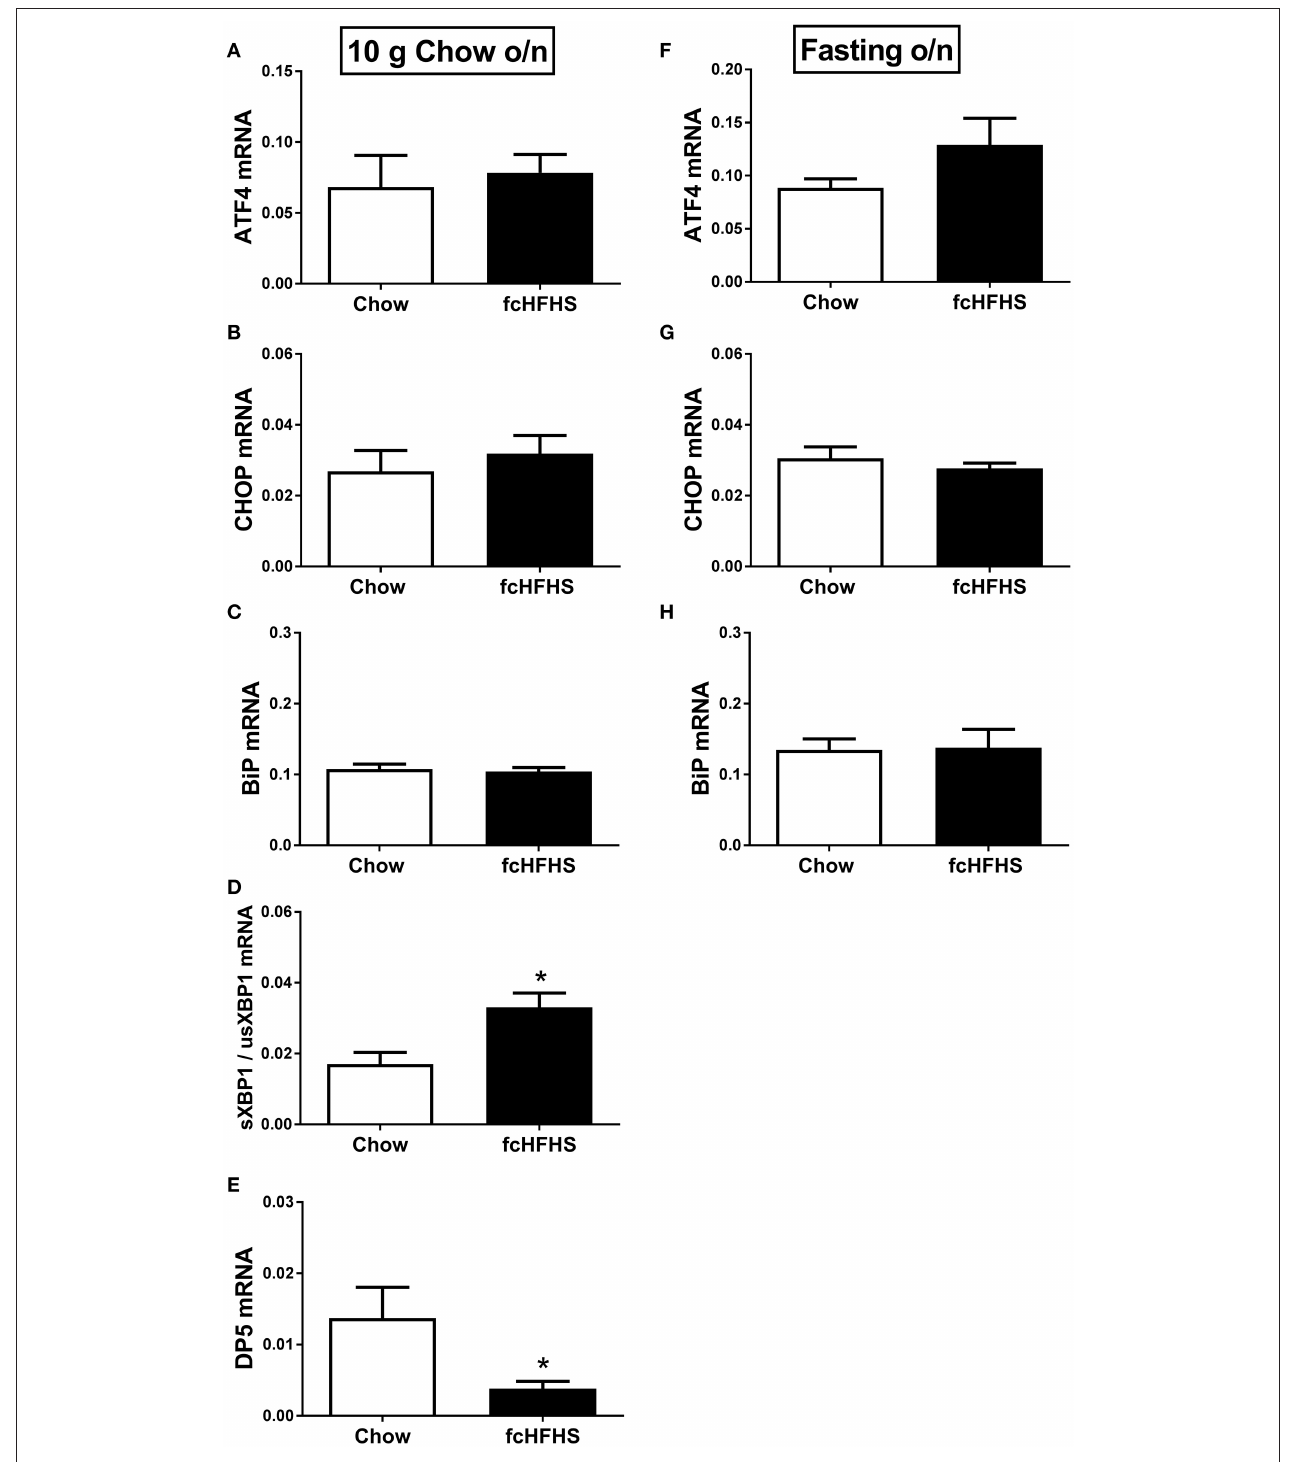
FIGURE 2 | The effect of overnight fat/sugar deprivation (10g chow; left column) or fasting (right column) after 1 week fcHFHS diet or chow on the mRNA expression of hypothalamic (A,F) ATF4, (B,G) CHOP, (C,H) BiP, (D) sXBP1/usXBP1, and (E) DP5. mRNA expression of specific genes was normalized to the geometric mean of three housekeeping genes. Significant differences between the fcHFHS and control groups: * p < 0.05.